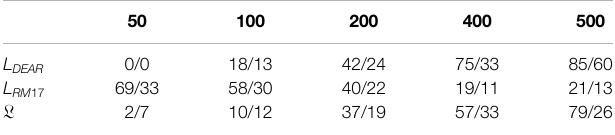
TABLE 1 | Bias and standard deviation (separated by a / ) of the boundary-layer height (in meters) for the IHOP